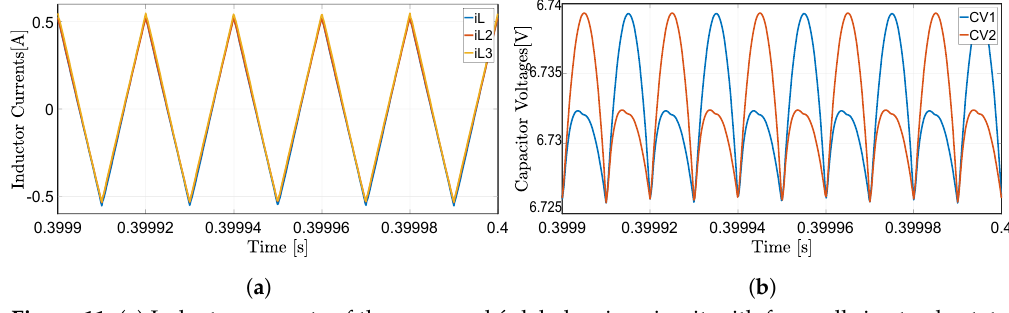
Figure 11. ( a ) Inductor currents of the proposed ´cuk balancing circuit with four cells in steady state; and ( b ) capacitor voltages of the proposed ´cuk balancing circuit with four cells in steady state.